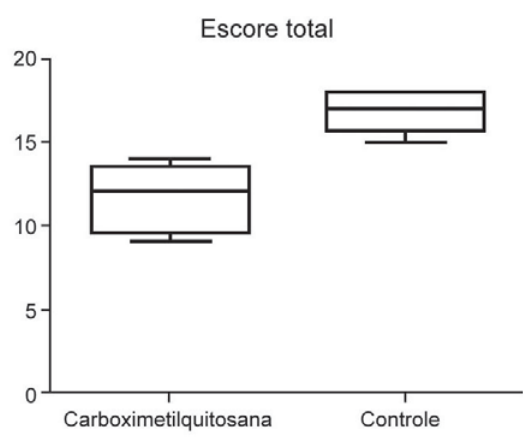
Fig. 5 - Curva de regressão linear entre gravidade das aderências e o tempo de